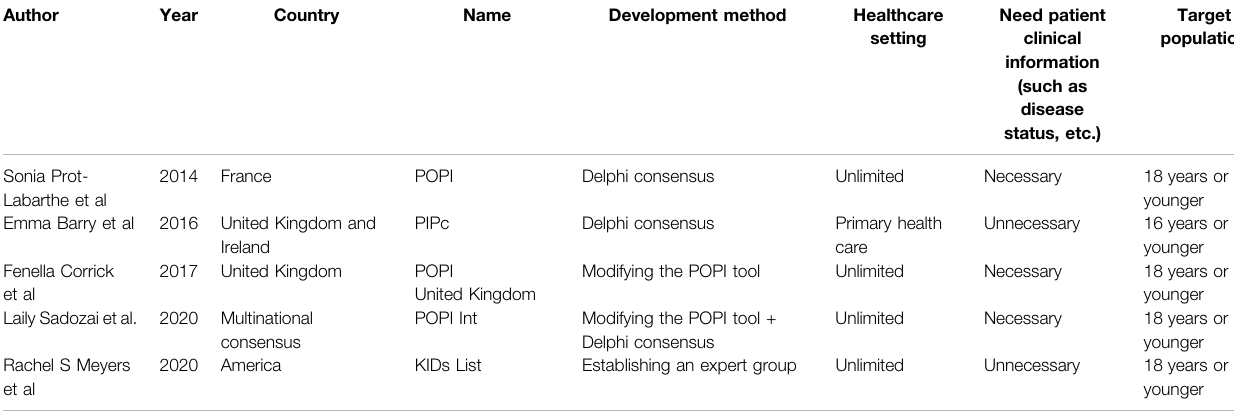
TABLE 1 | Basic characteristics of children ’ s PIP screening